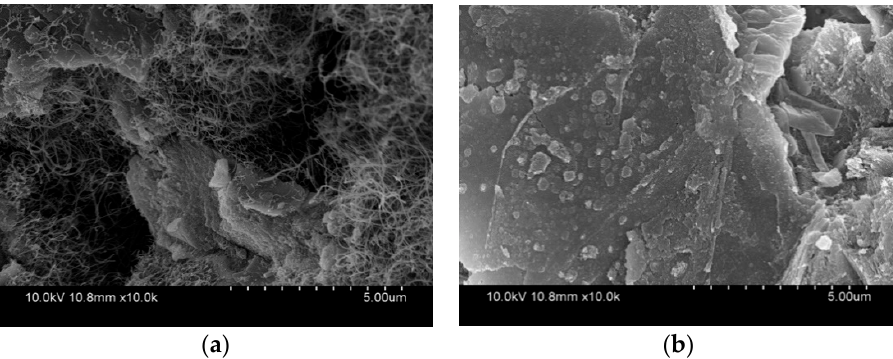
Figure 6. Scanning electric microscopy (SEM) images of Ni-based catalysts after reforming reactions: ( a ) steam reforming at 800 °C, S/C = 3.0, and O 2 /C = 0.2; and ( b ) auto-thermal reforming at 800 °C, S/C = 3.0, and O 2 /C = 0.2.